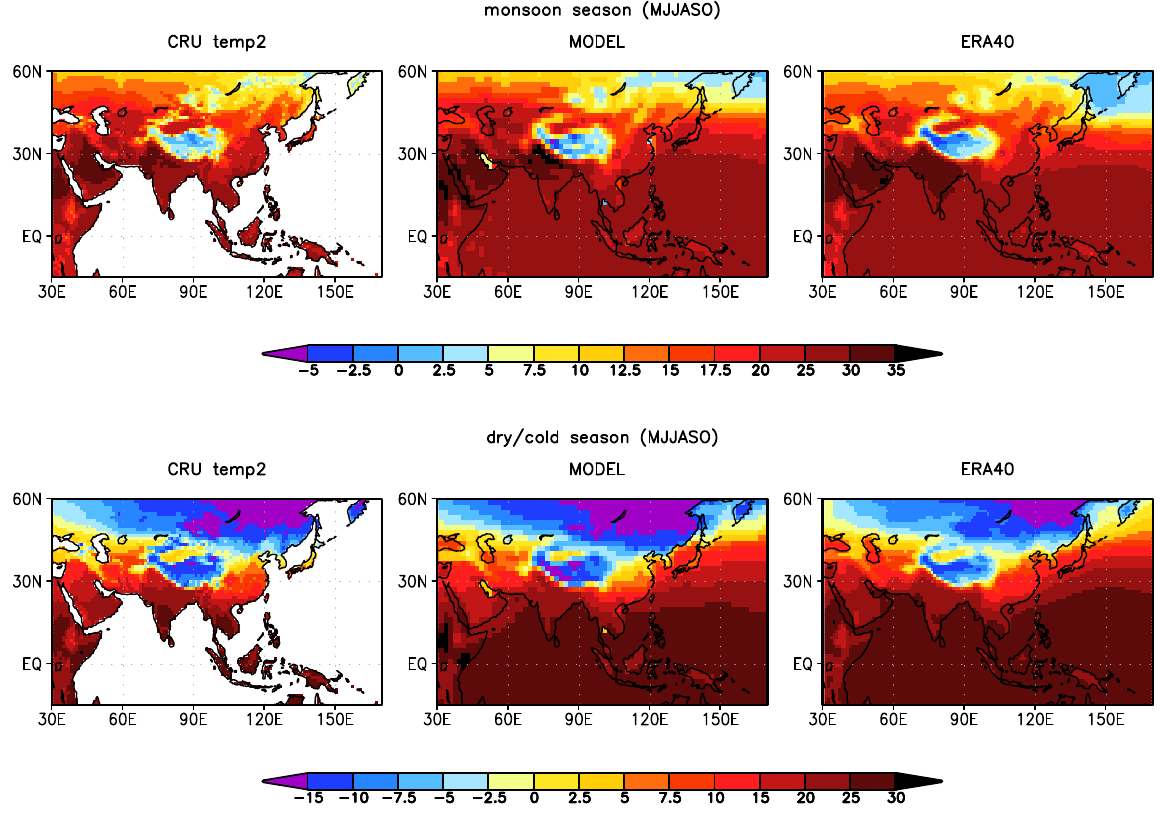
Fig. A1. Simulated near-surface air temperature [ ◦ C] compared to the observational dataset CRU TS 2.1 (Mitchell and Jones, 2005) and ERA40 reanalysis data (Simmons and Gibson, 2000), averaged over the monsoon season (May–October) and the dry/cold season (November–April). Values are taken from the CTRL simulation. CRU TS 2.1 does not include oceanic